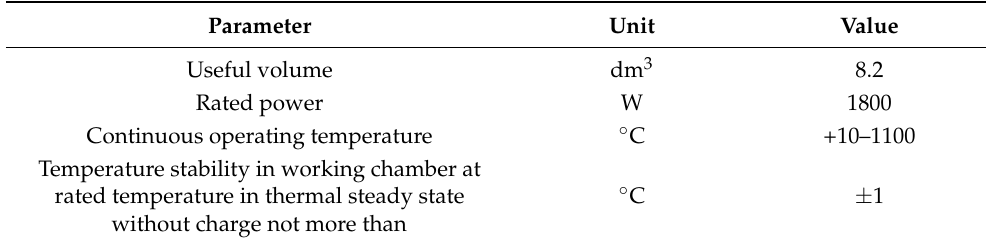
Table 3. Technical specification of SNOL 8.2/1100 muffle